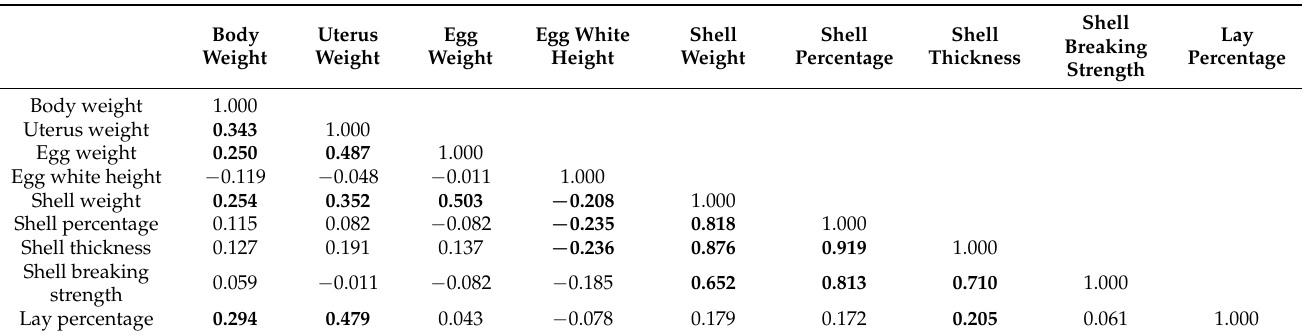
Pearson’s correlation analyses for egg properties, reported in Table 3, show some interesting relationships among measured parameters. For instance, body weight was positively correlated to uterus weight, egg weight, shell weight and lay percentage. The uterus weight was positively correlated to egg weight, shell weight and lay percentage ( p < 0.001). The eggshell breaking strength was highly and positively correlated with shell weight, shell thickness and even more strongly to shell percentage (R = 0.831; p < 0.001). Table 3. Pearson’s correlation between egg related